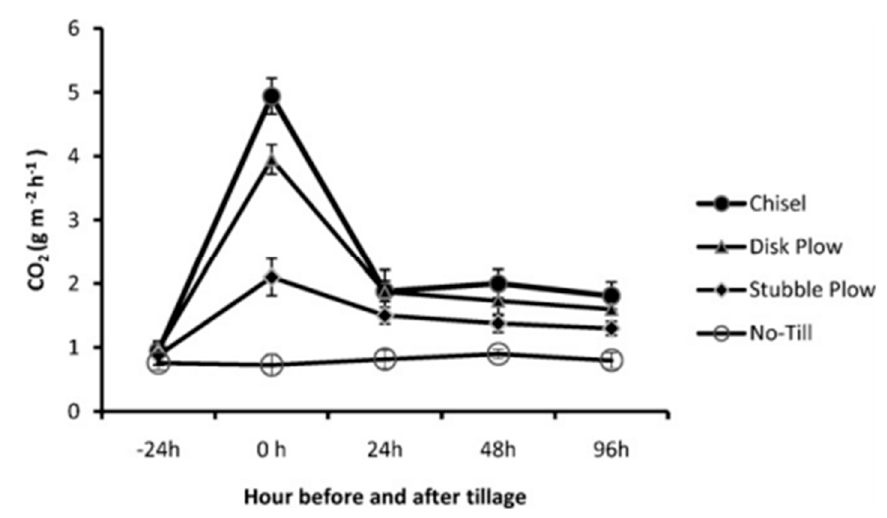
Figure 4. Soil CO 2 flux associated with primary full tillage as compared to no tillage (NT) systems [22].